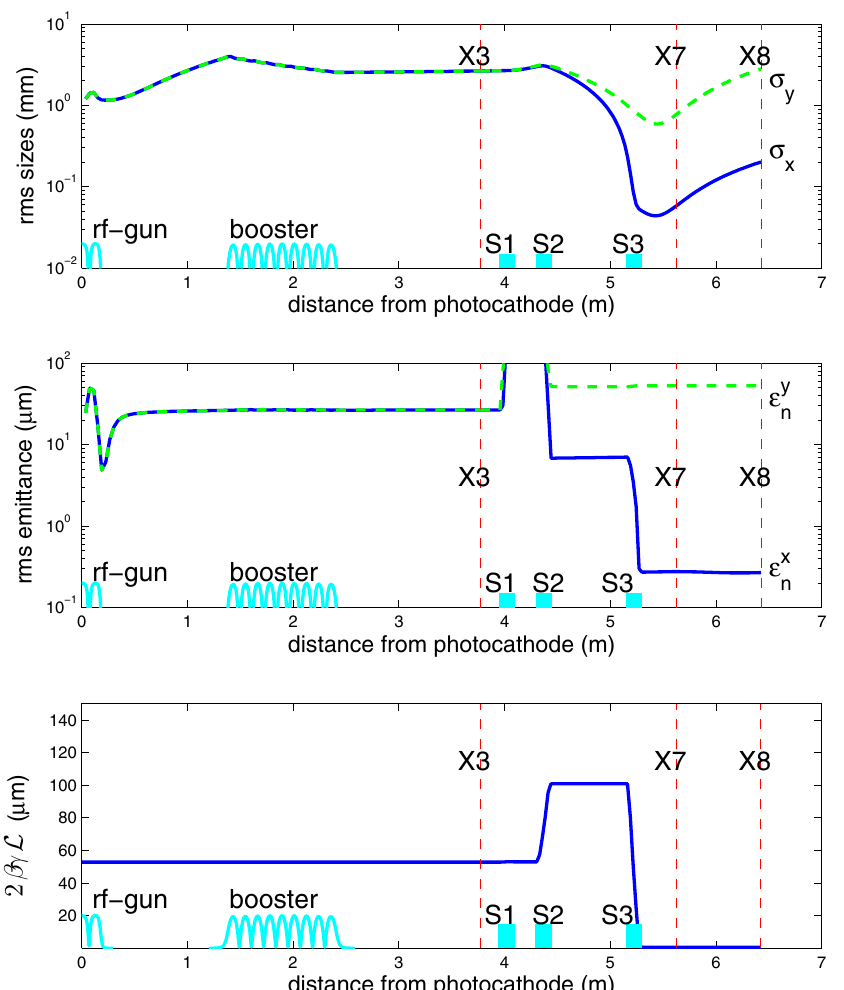
FIG. 2. (Color) Evolution of beam rms transverse sizes (top), normalized emittances (middle), and angular momentum (bottom) along the FNPL beam line from the photocathode up to viewer X8 [the simulation corresponds to the case (cid:2) details)]. The vertical dash lines and the filled boxes, respectively, represent the viewer and skew quadrupole locations. The maximum values for the horizontal and vertical emittances (middle plot) are, respectively, 365 and 417 (cid:1) m (these values are reached between quadrupoles S1 and